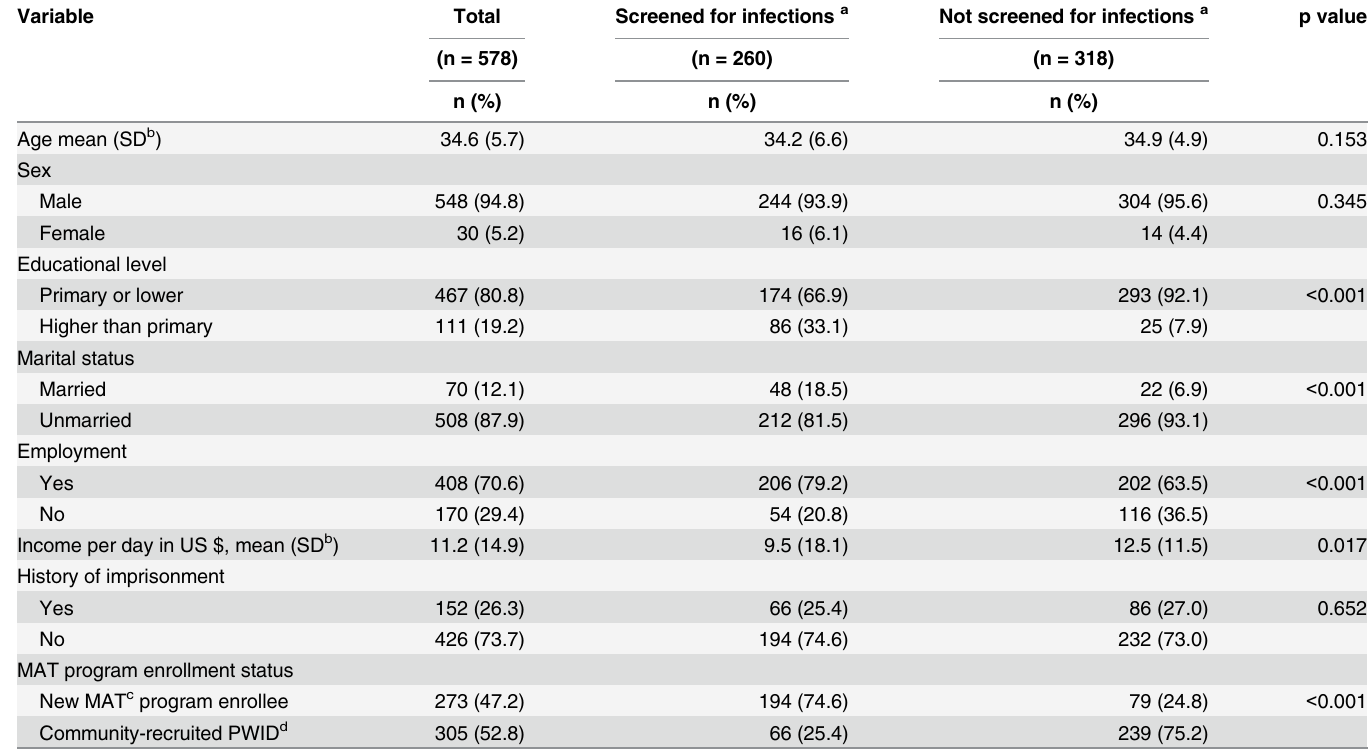
Table 1. Sociodemographic characteristics and history of imprisonment of